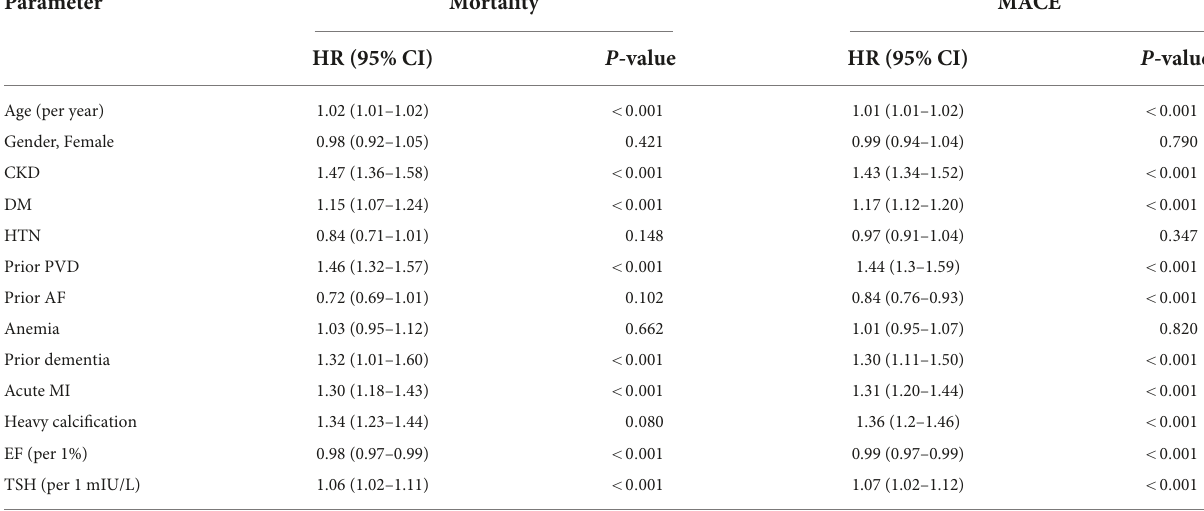
TABLE 3 Cox regression analyses for mortality and MACE at 5